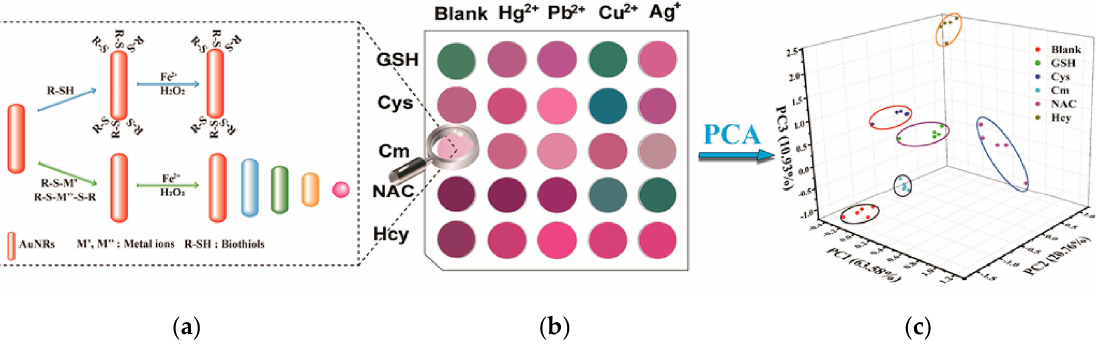
Figure 2. Label-free AuNRs sensor array for colorimetric detection of biothiols. Reproduced with permission from [47]. (a) Synthesis of various AuNRs; (b) Fingerprint-like colorimetric array for metal ions; (c) Principal component analysis. Copyright Talanta, 2019.